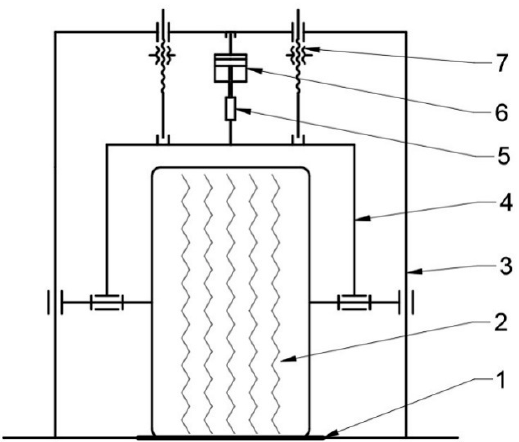
Figure 1. Scheme of the test bench: 1—non-deformable surface, 2—wheel with tested tire, 3—external frame, 4—internal frame, 5—force sensor, 6—hydraulic jack, 7—screw mechanism.